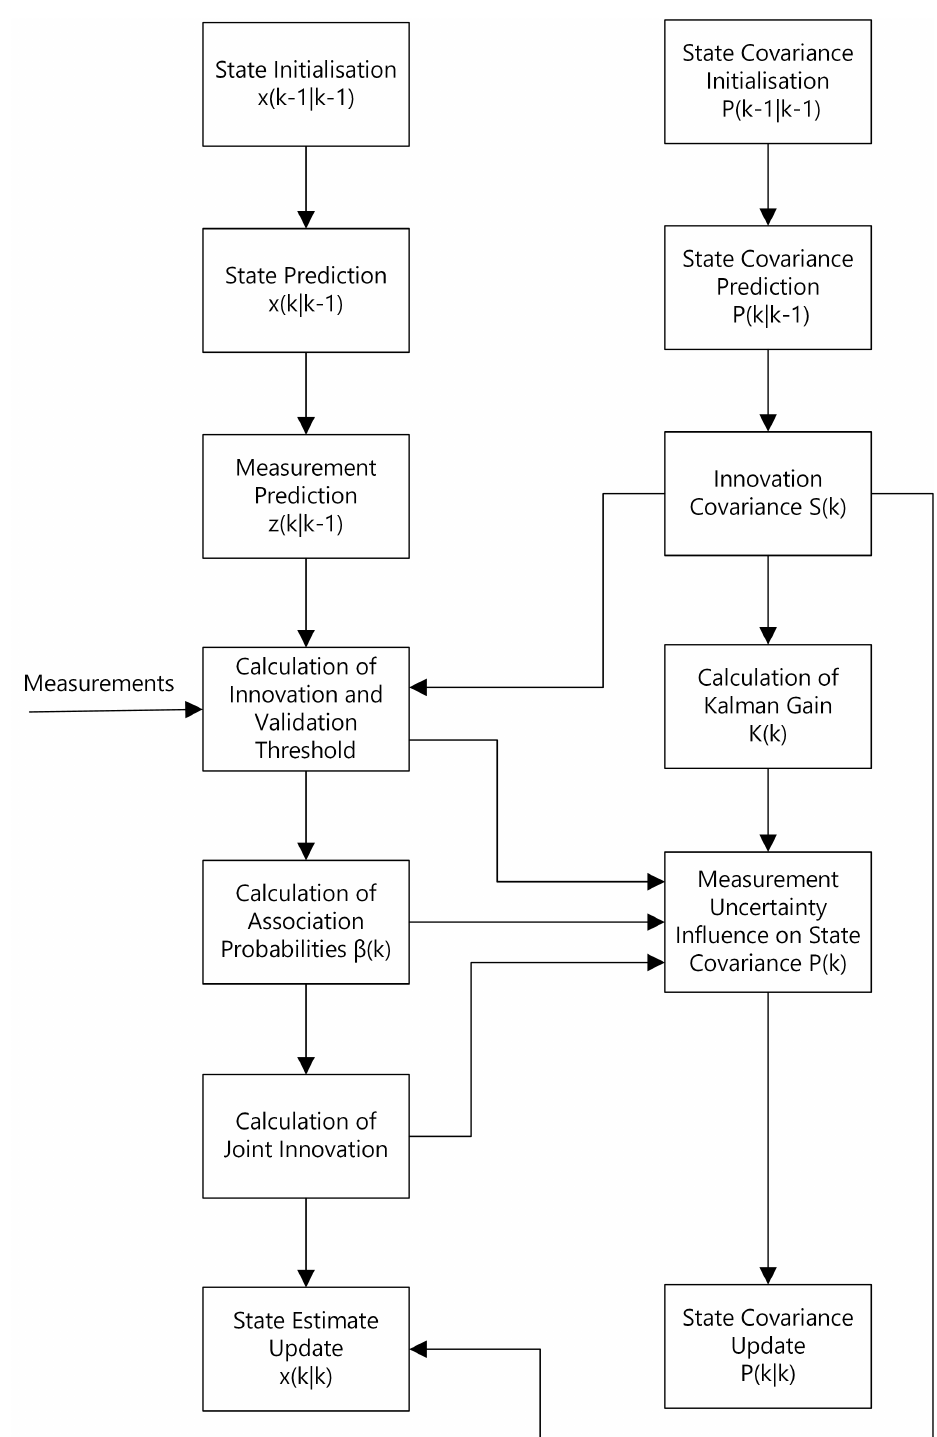
Figure 3. Probabilistic Data Association (PDA) algorithm block diagram based on